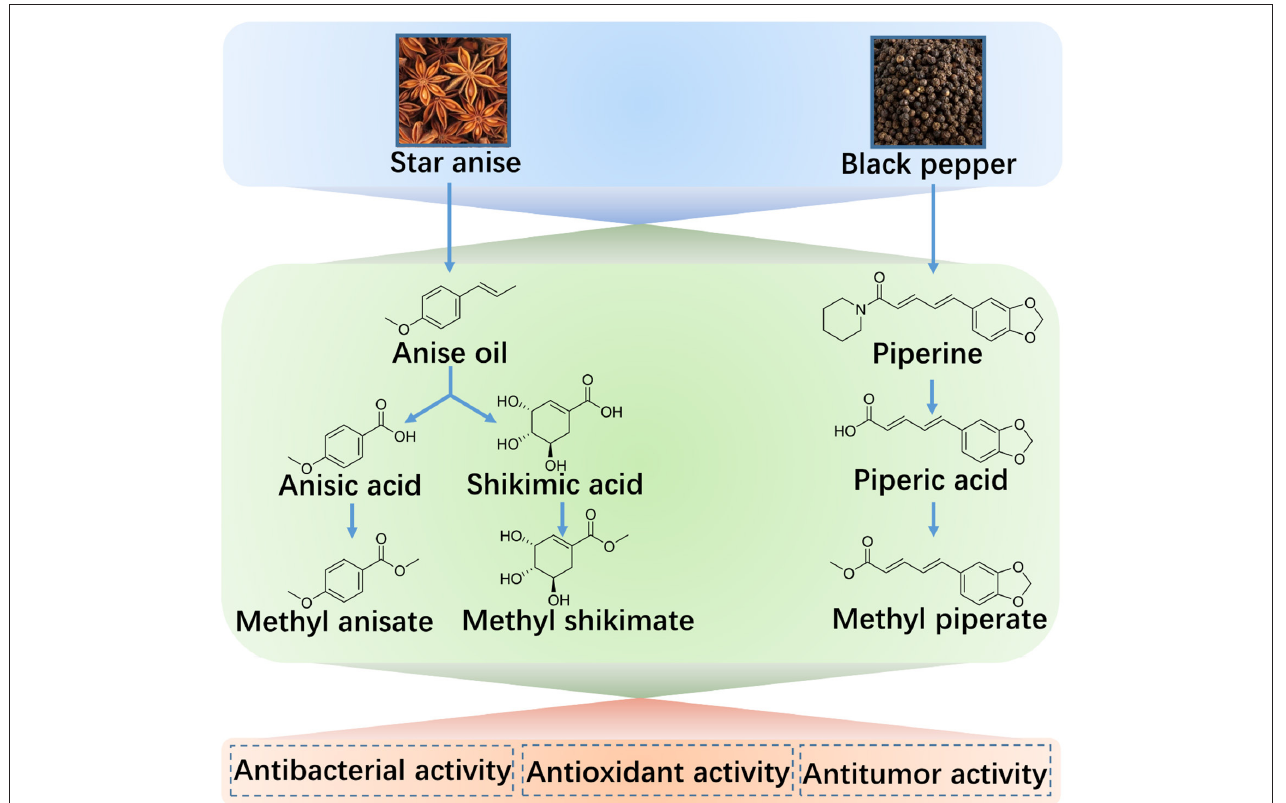
SCHEME 1 | Schematic illustration of star anise or black pepper extractives and their